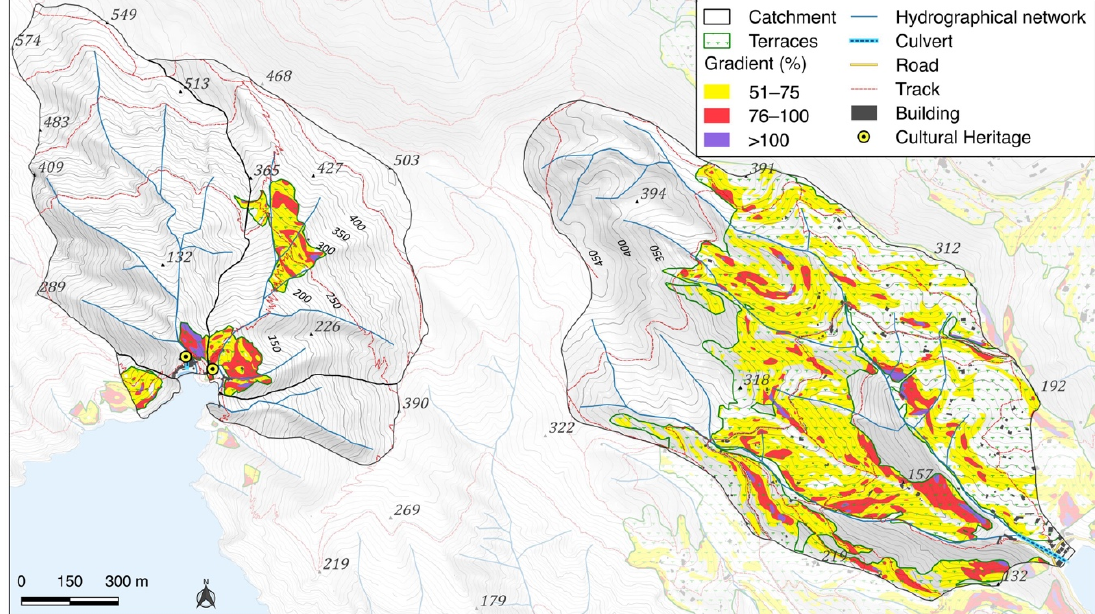
Figure 10. Terraces on higher class slope gradients are highlighted: they correspond to the higher hazard of instability. The main exposed elements are buildings, Cultural Heritage, culverts and roads.